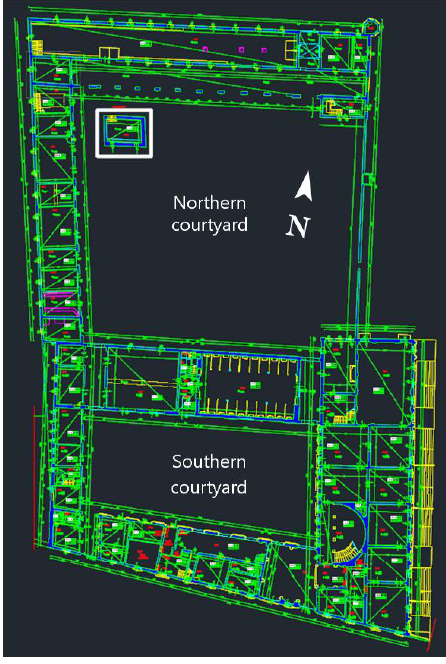
Figure 12: Floor plan of the ground level